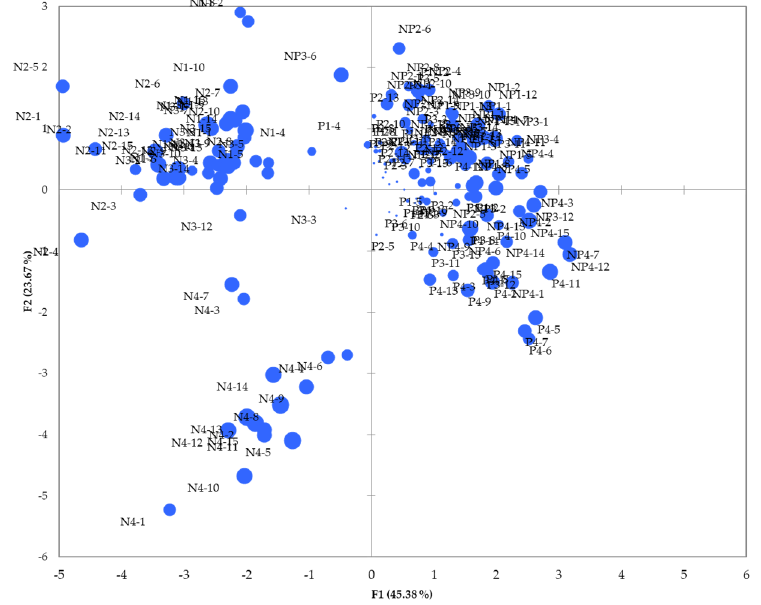
Figure 3. Soil biological characteristics distribution in PCA. (N: no hunting; P: protected area; NP: national park).